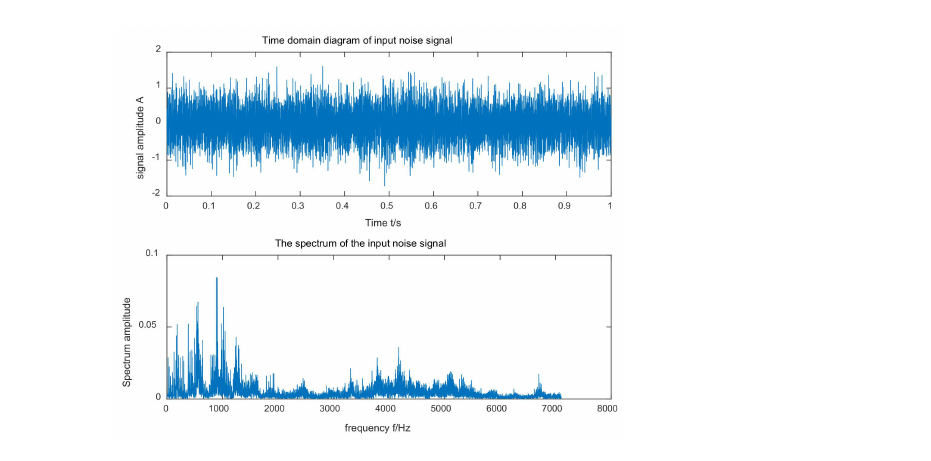
Figure 9. Input signal time domain waveform and FFT spectrum for the XJTU-SY bearing dataset.